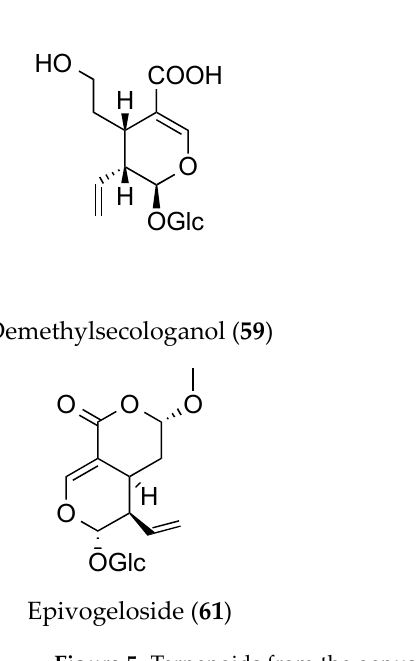
Figure 5. Terpenoids from the genus of Ophiorrhiza. *Glc = glucose molecule. Table 4. Terpenoids content in Ophiorrhiza